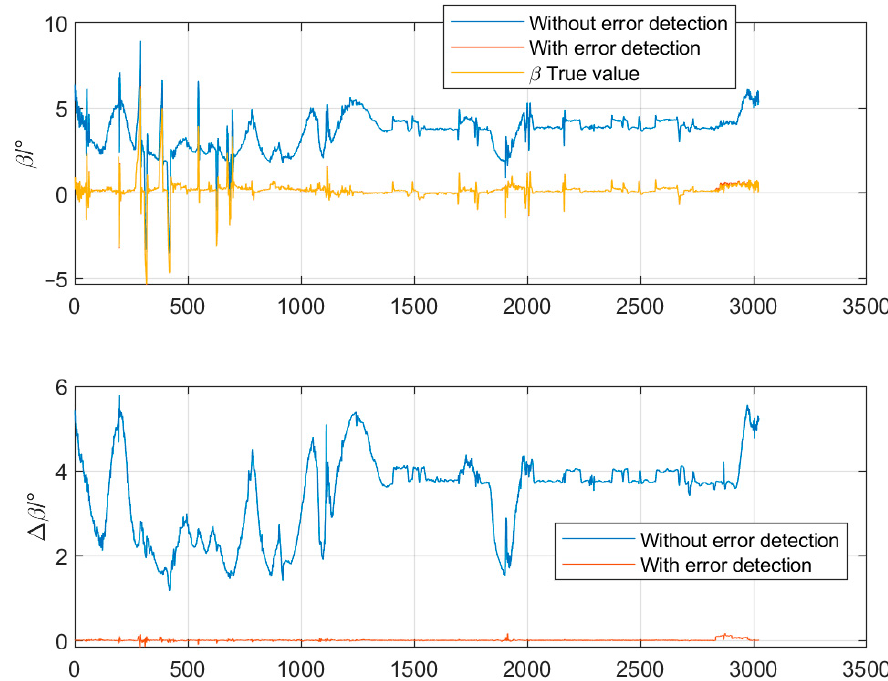
Figure 16. Comparisons of sideslip angle.